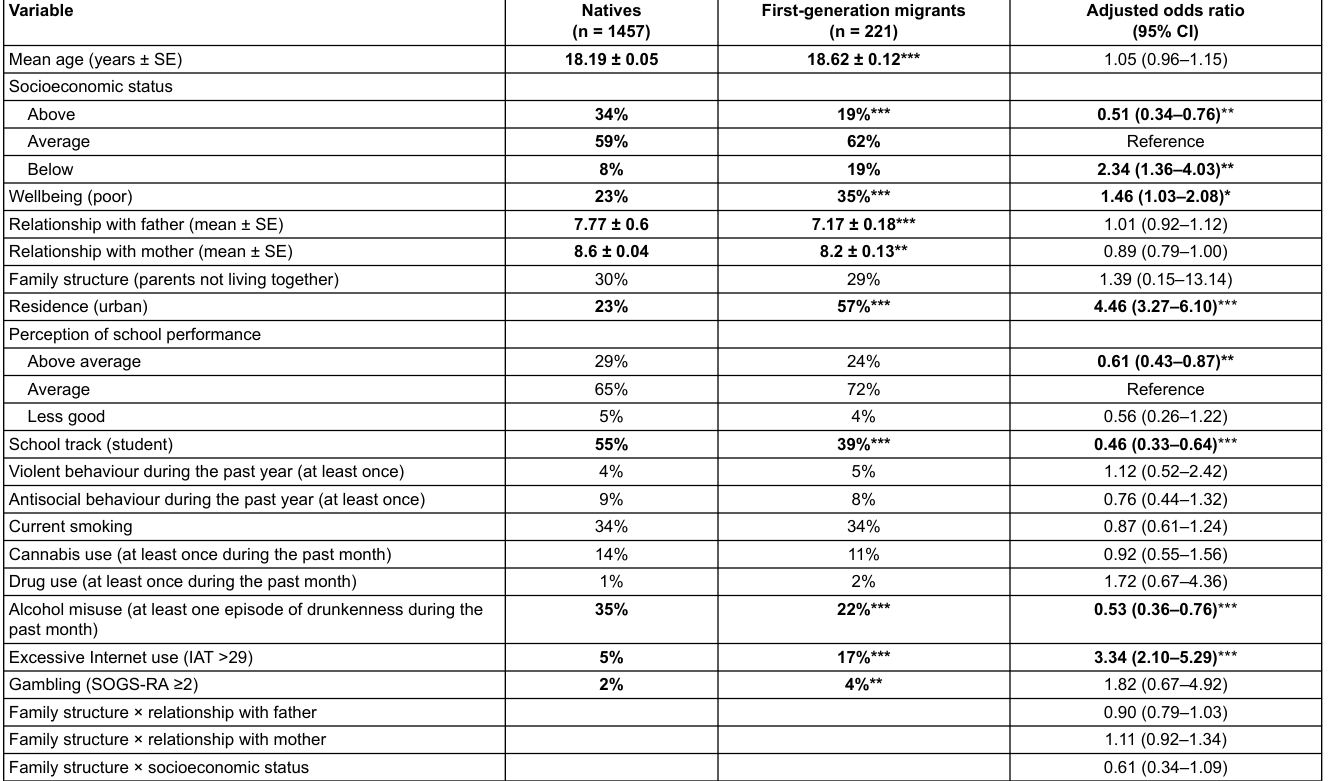
Table 4: Girls: comparison of first-generation migrants vs natives in the age group 15–24 years in post-mandatory schools.